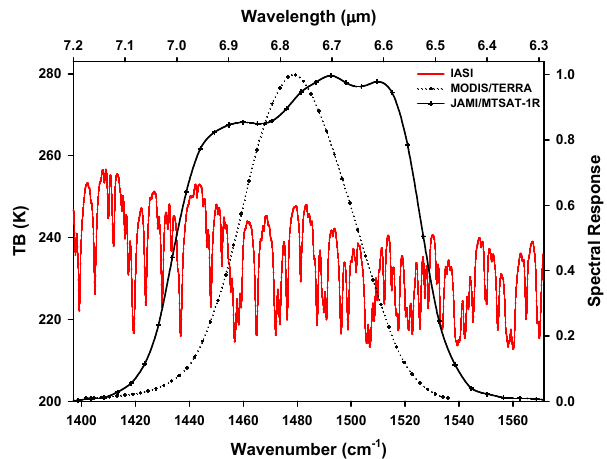
Figure 1: The normalized spectral response functions of the MODIS and MTSAT-1R 6.8 µ m Fig. 1. The normalized spectral response functions of the MODIS water vapor channels. The IASI spectrum collected at 00:30 UTC 16 June 2007 at the and MTSAT-1R 6.8µm water vapor channels. The IASI spec- location (3.22 ° N, 140.06 ° E) is overlaid. trum collected at 00:30UTC 16 June 2007 at the location (3.22 ◦ N, 140.06 ◦ E) is